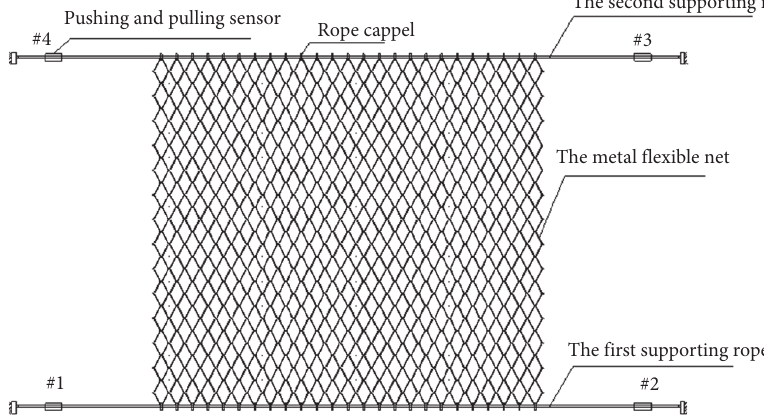
Figure 2: The arrangement scheme of experiment.